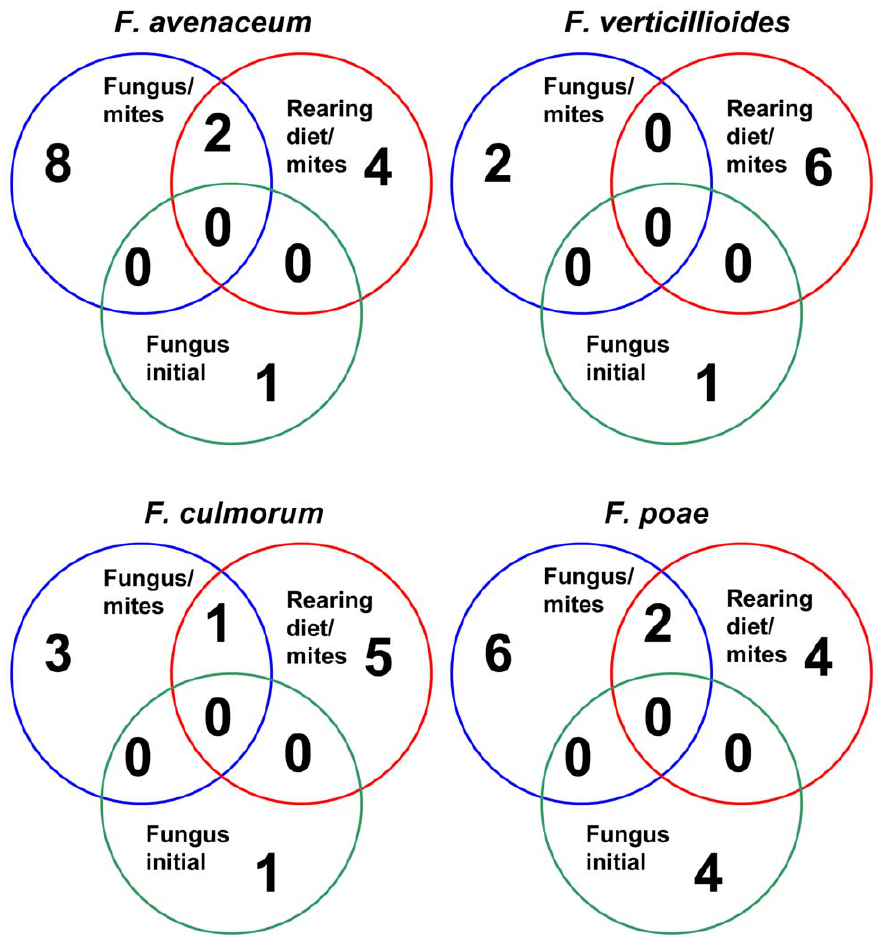
Figure 3. Comparison of bacterial communities based on operational taxonomic units (OTU) defined at distance 0.06 using Venn diagram. The numbers of OTU are presented separately for initial situation (fungus before mite introduction) and mites feeding on rearing diet and fungal diet.